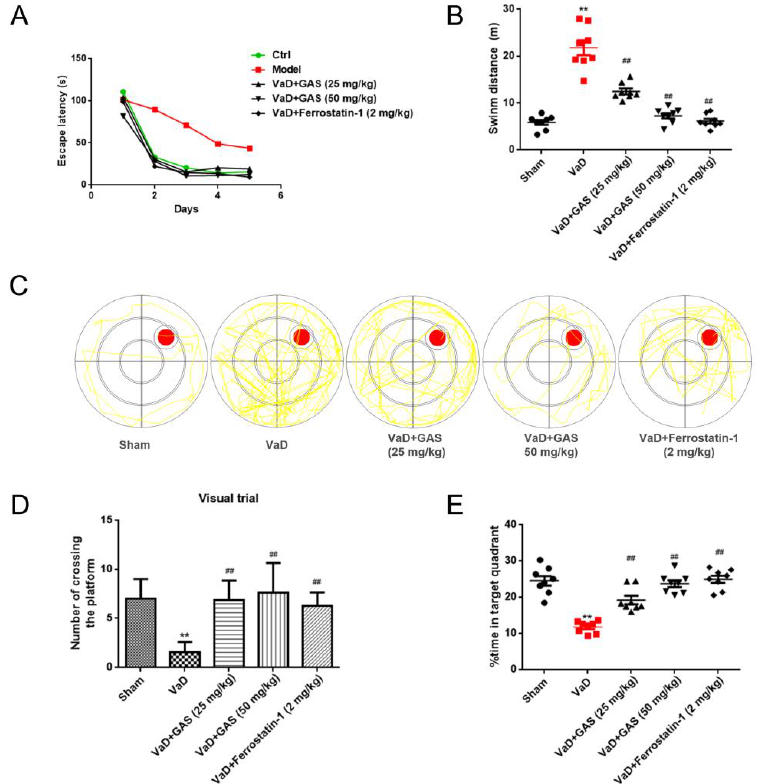
Figure 1. Neuroprotective effect of GAS on learning and memory impairment in VaD rats. ( A ), Escape latency ( B ), swimming distance in less than 2 min ( C ), swimming track diagram, red circle: the location of the platform; yellow line: the track of the first landing on the platform. ( D ), The number of times crossing the platform ( E ), Percentage of time spent on target project. Results are shown as mean ± SD ( n = 6). ** p < 0.01 specifies the differences between sham rat and VaD rat. ## p < 0.01 compares between VaD rat and GAS-treated rat or ferrostatin1-treated rat.